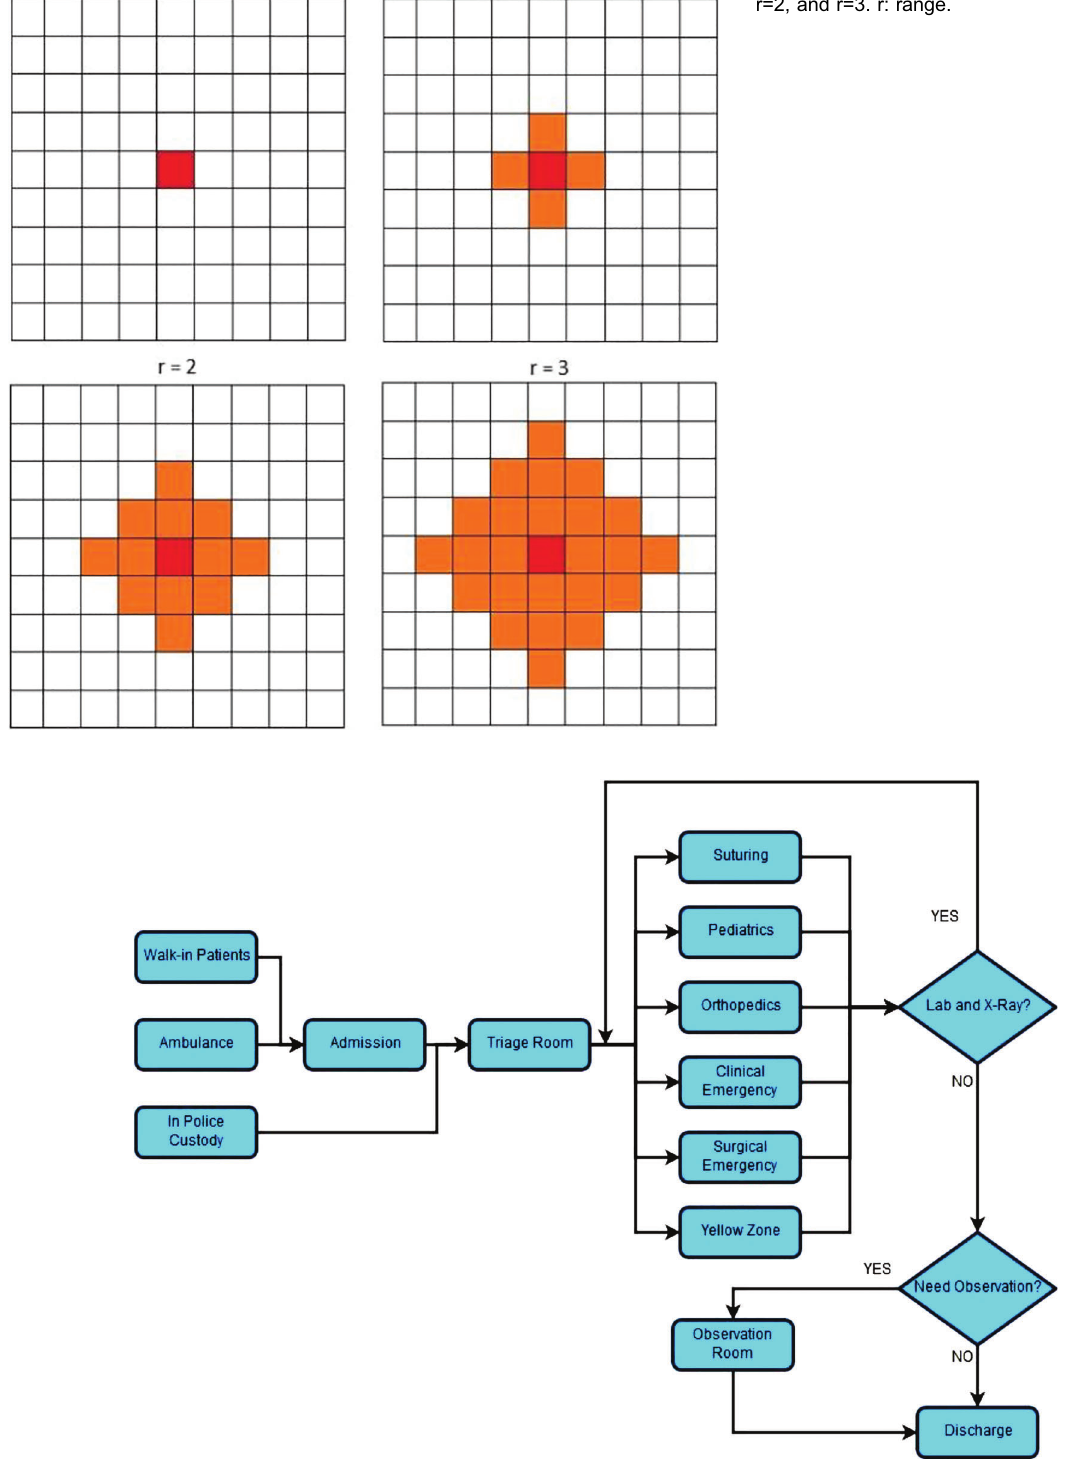
Figure 8. Flow of patients at an emergency